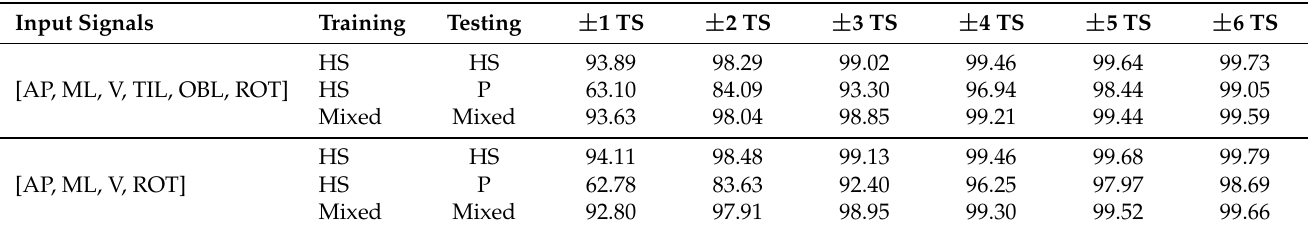
Table 4. Accuracy results when patient data is